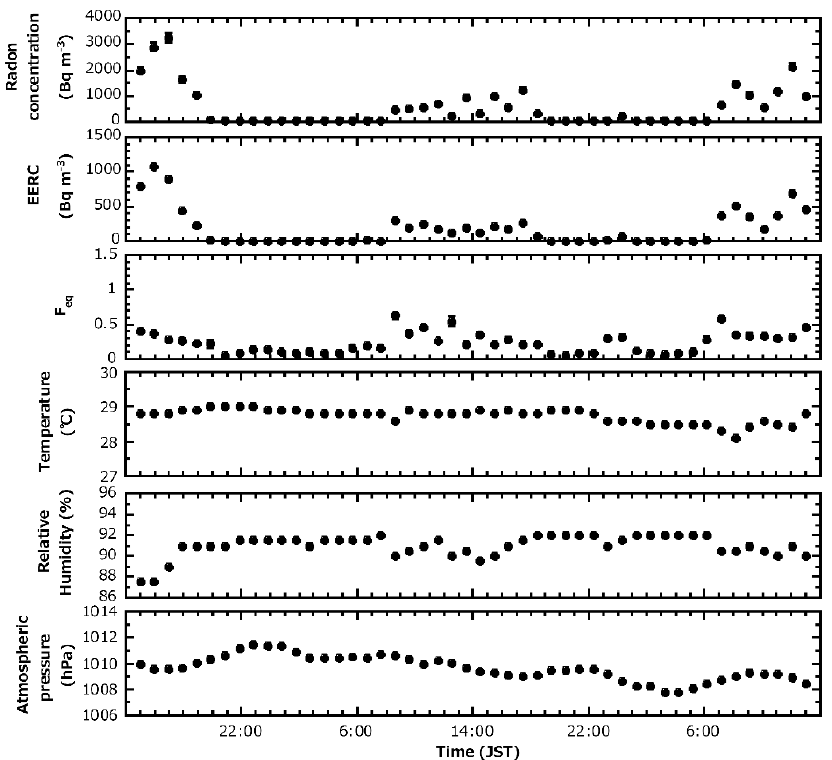
Figure 6. Measurement results in summer.